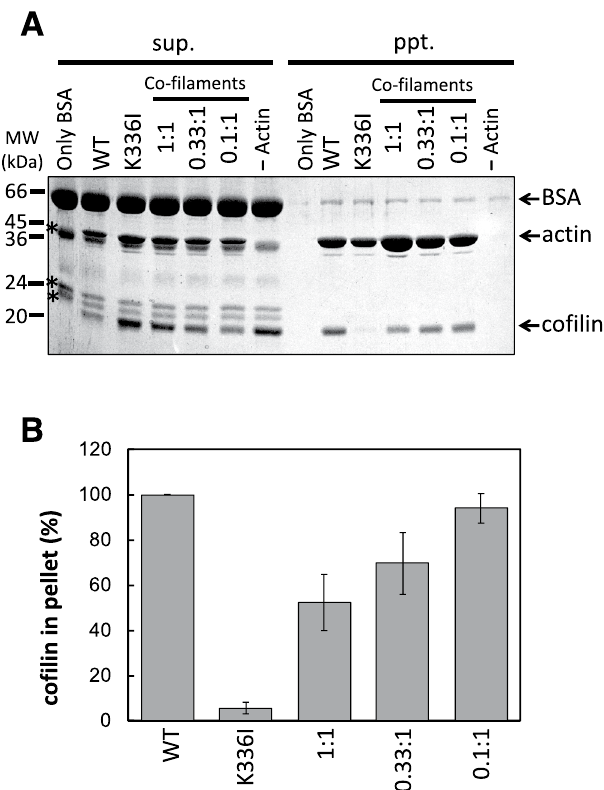
Figure 4. Cofilin binding. ( A ) Co-sedimentation of 2.5 µ M cofilin with 5 µ M K336I homo-filaments, 5 µ M WT homo-filaments, and K336I/WT co-filaments consisting of 5 µ M WT actin and 5 (1:1), 1.7 (0.33:1), or 0.5 µ M (0.1:1) K336I mutant actin was analysed by SDS-PAGE. sup, supernatant; ppt, pellet after ultracentrifugation. Asterisks indicate contaminating proteins present in the BSA solution. Full-length gel image is shown in Supplementary Fig. S8. ( B ) Densitometric analysis of three Coomassie-stained SDS-gels, including the one shown in ( A ), determined that 5.6 ± 2.6%, 52.2 ± 12.4%, 69.5 ± 13.6%, and 93.9 ± 6.5% (mean ± SE) of cofilin co-sedimented with K336I homo-filaments, 1:1, 0.33:1, and 0.1:1 co-filaments, respectively. The amount of cofilin in each pellet was normalized to the amount in the pellet of WT